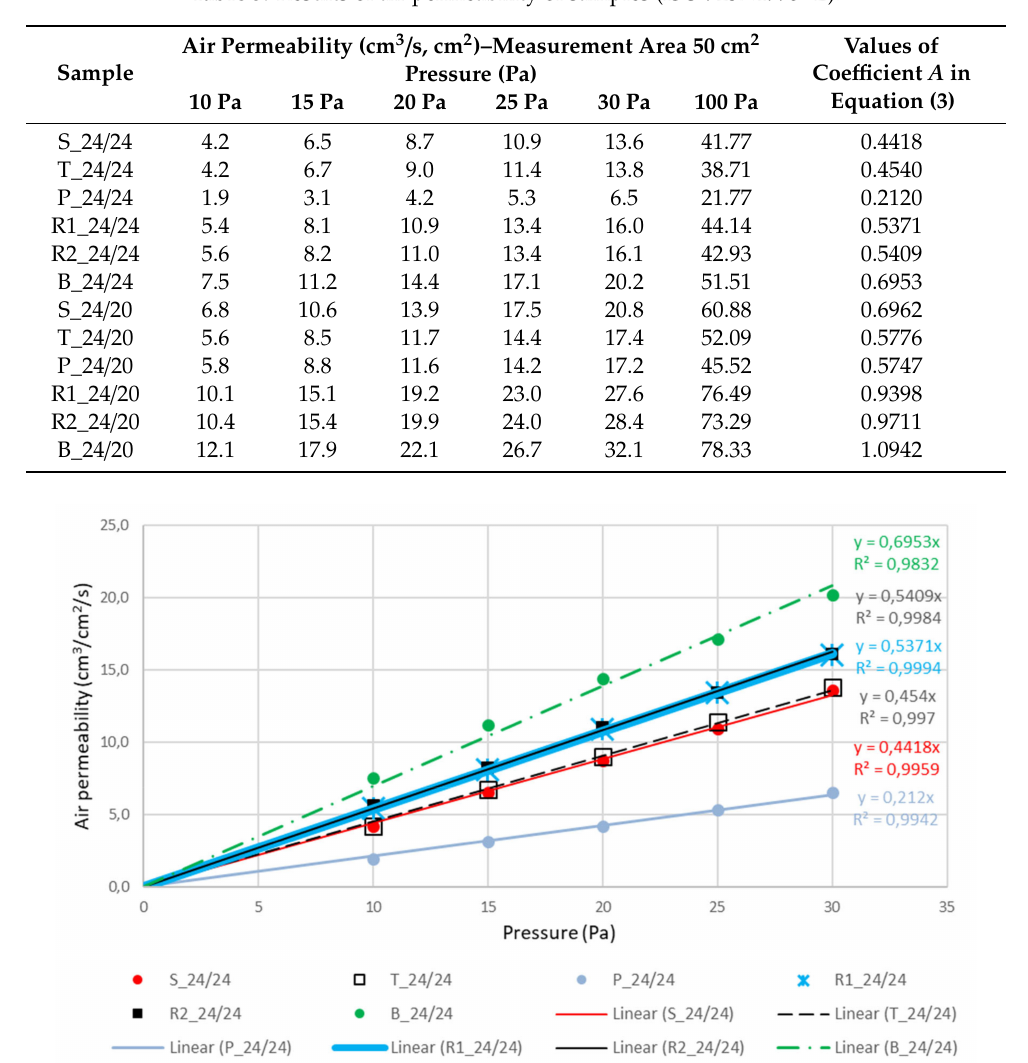
Table 5. Results of air permeability of samples (ISO 9237:1995 -E).